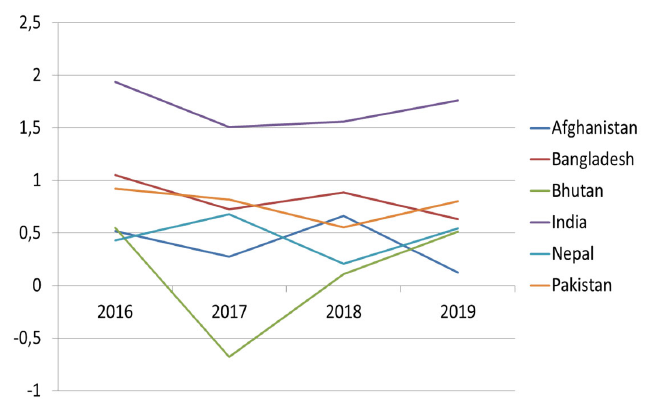
Fig. 5. Foreign direct investment, net inflow of 6 south Asian countries (% of GDP) Source: World